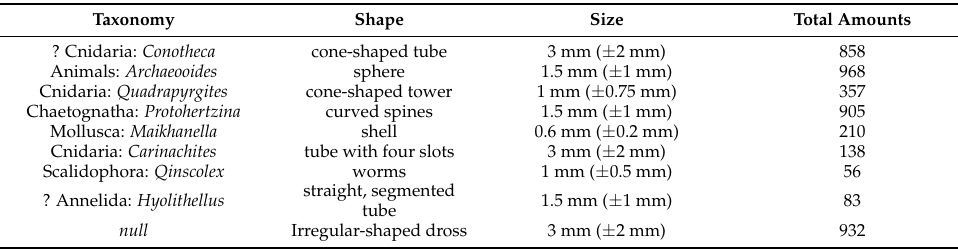
Table 1. Basic information on nine